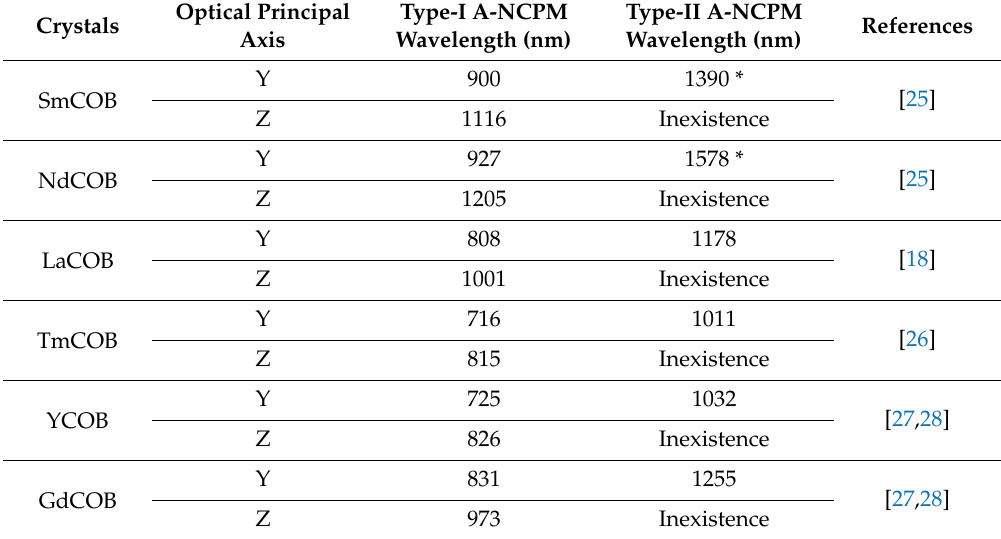
Table 1. Angular non-critical phase-matching second-harmonic-generation (A-NCPM SHG) wavelengths of pure RECOB crystals.